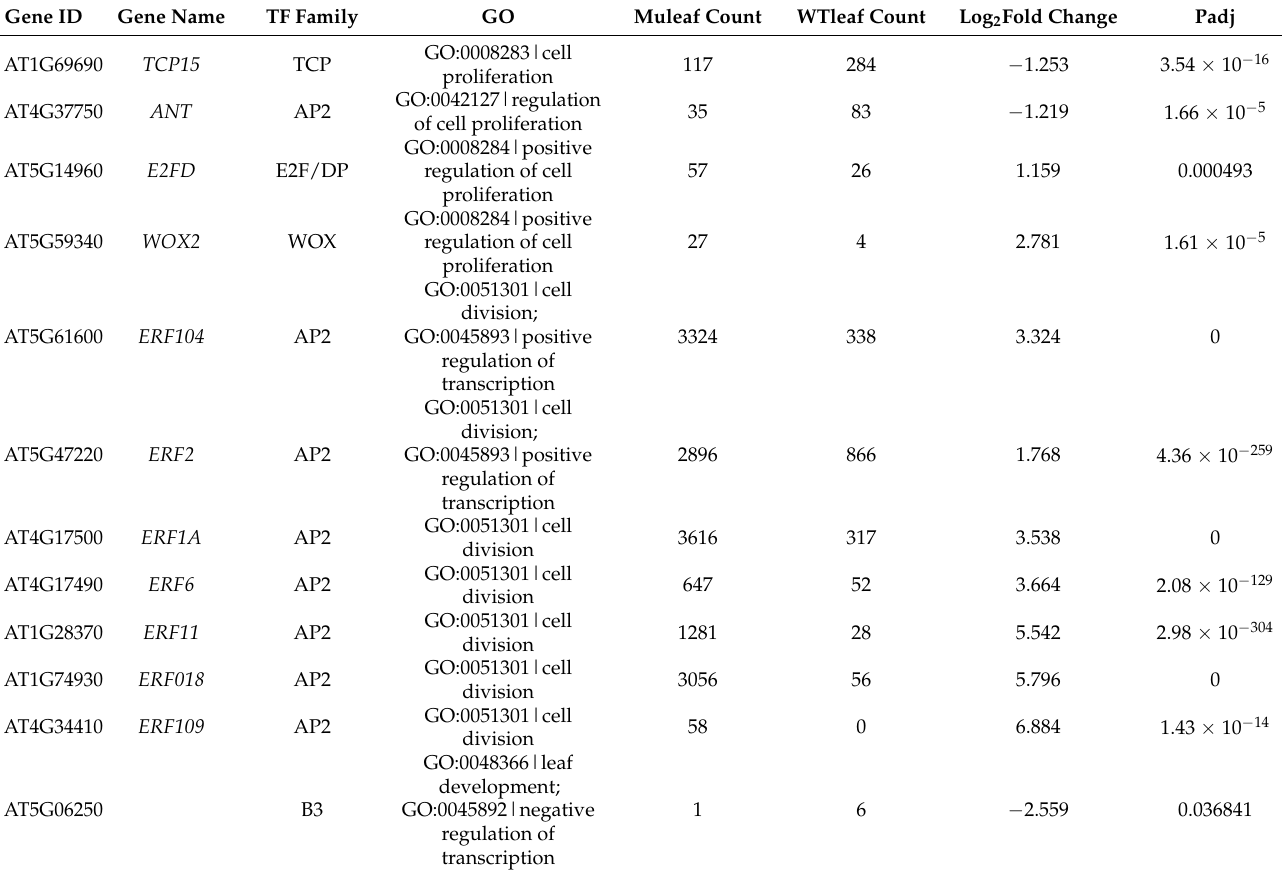
Table 3. Analysis of TFs related to leaf development in the pip1s − mutant and WT